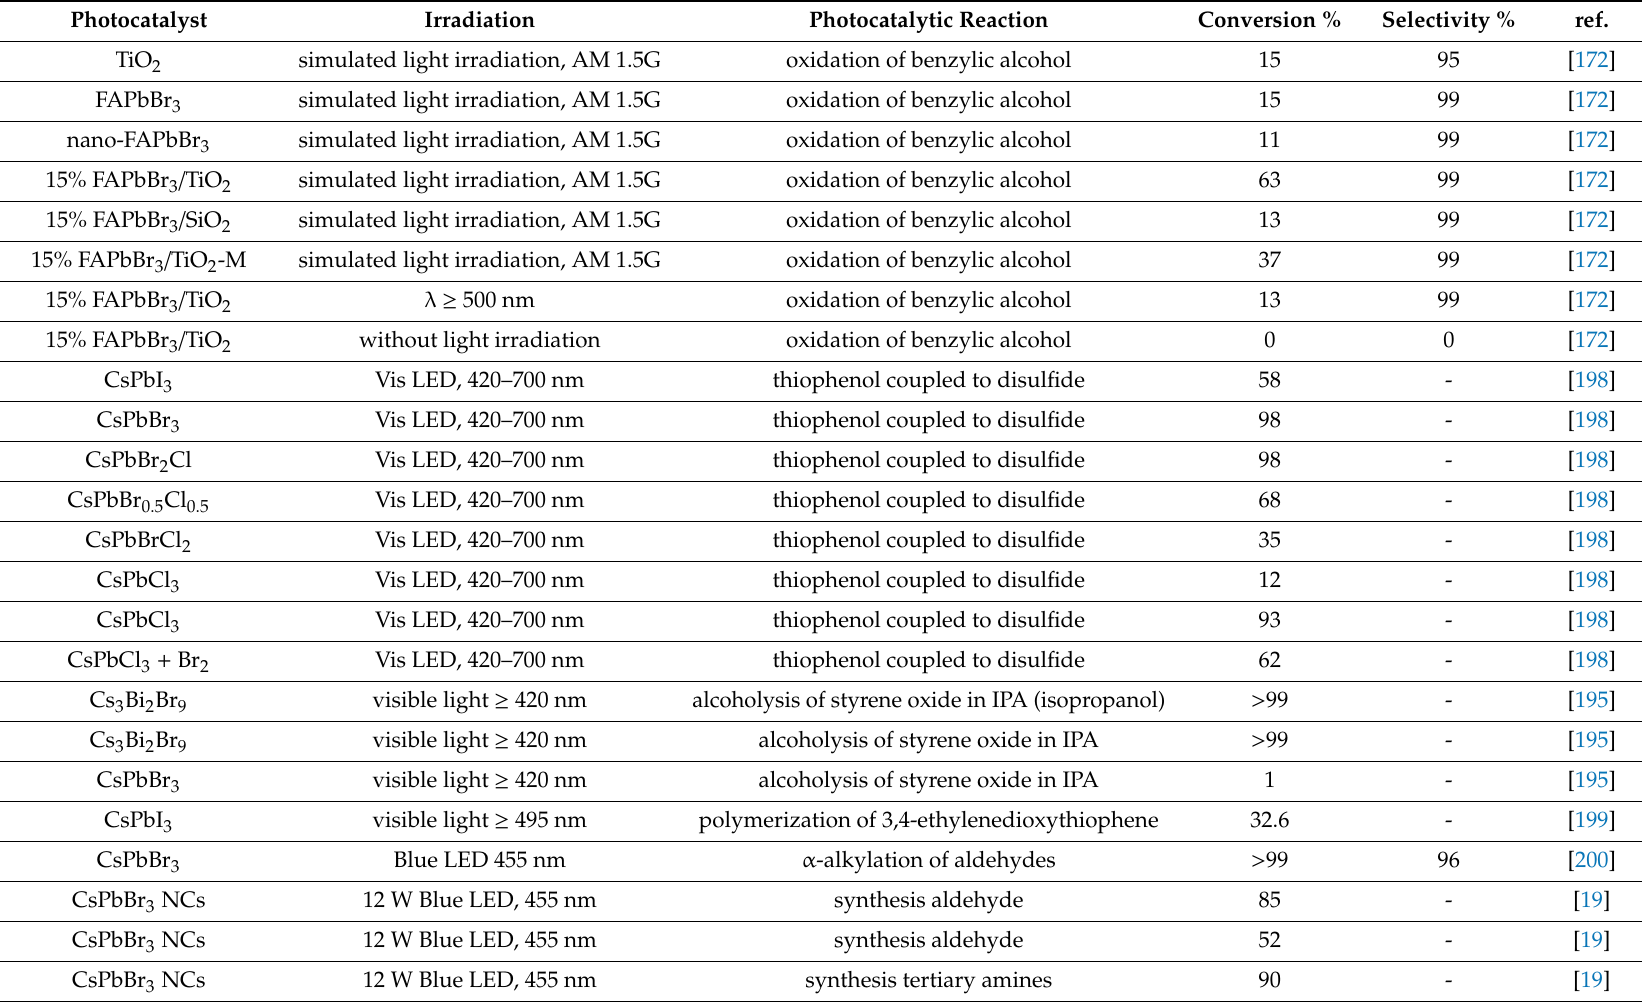
Table 5. Comparison in di ff erent organic synthesis reactions of di ff erent metal halide perovskites and their composites, reported in the